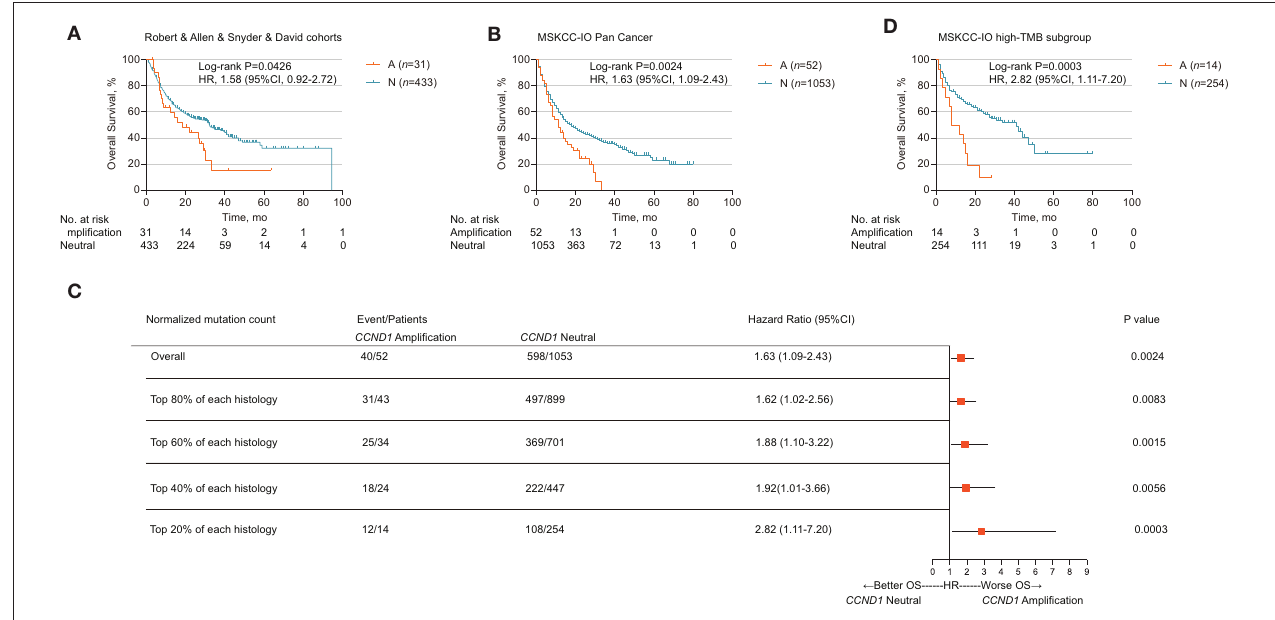
FIGURE 2 | Association of cyclin D1 (CCND1) amplification with prognosis in the Memorial Sloan Kettering Cancer Center (MSKCC)-IO cohort. (A) Kaplan–Meier survival analysis of overall survival (OS) comparing the CCND1 amplification and neutral groups in patients with melanoma treated with immune checkpoint inhibitors (ICIs) from the Robert, Allen, Snyder, and David cohorts ( n = 464). (B) Kaplan–Meier survival analysis of OS comparing the CCND1 amplification and neutral groups in patients with solid tumors treated with ICIs in the MSKCC-IO pan-cancer cohort ( n = 1,105). (C) Hazard ratios of CCND1 status across patients with different levels of tumor mutational burden (TMB) in the MSKCC-IO pan-cancer cohort ( n = 1,105). (D) Kaplan–Meier survival analysis of OS comparing the CCND1 amplification and neutral groups in patients with solid tumors treated with ICIs identified with top 20% TMB within each histology in the MSKCC-IO cohort ( n = 268).